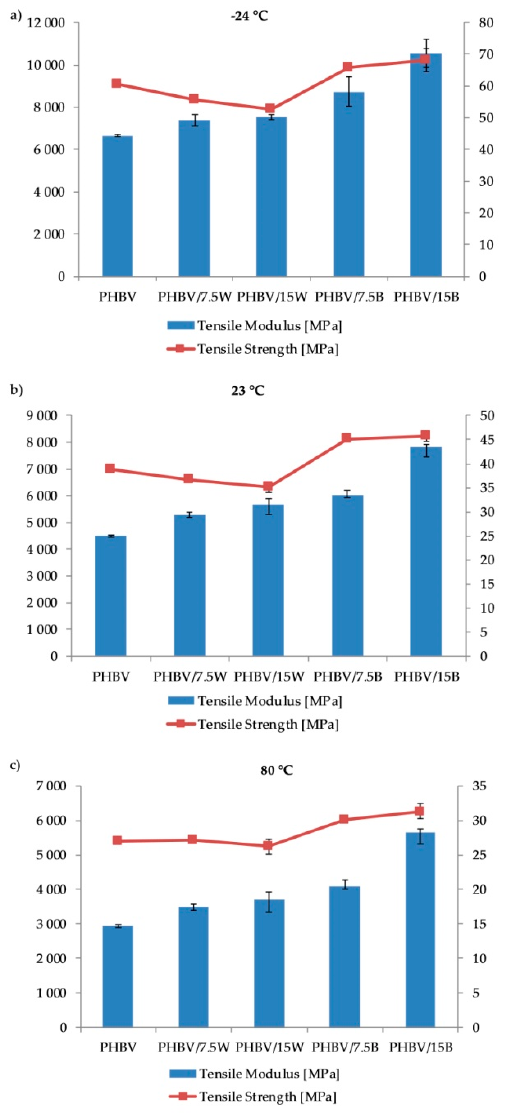
− 24 ( a ), 23 ( b ) and 80 ◦ C ( c